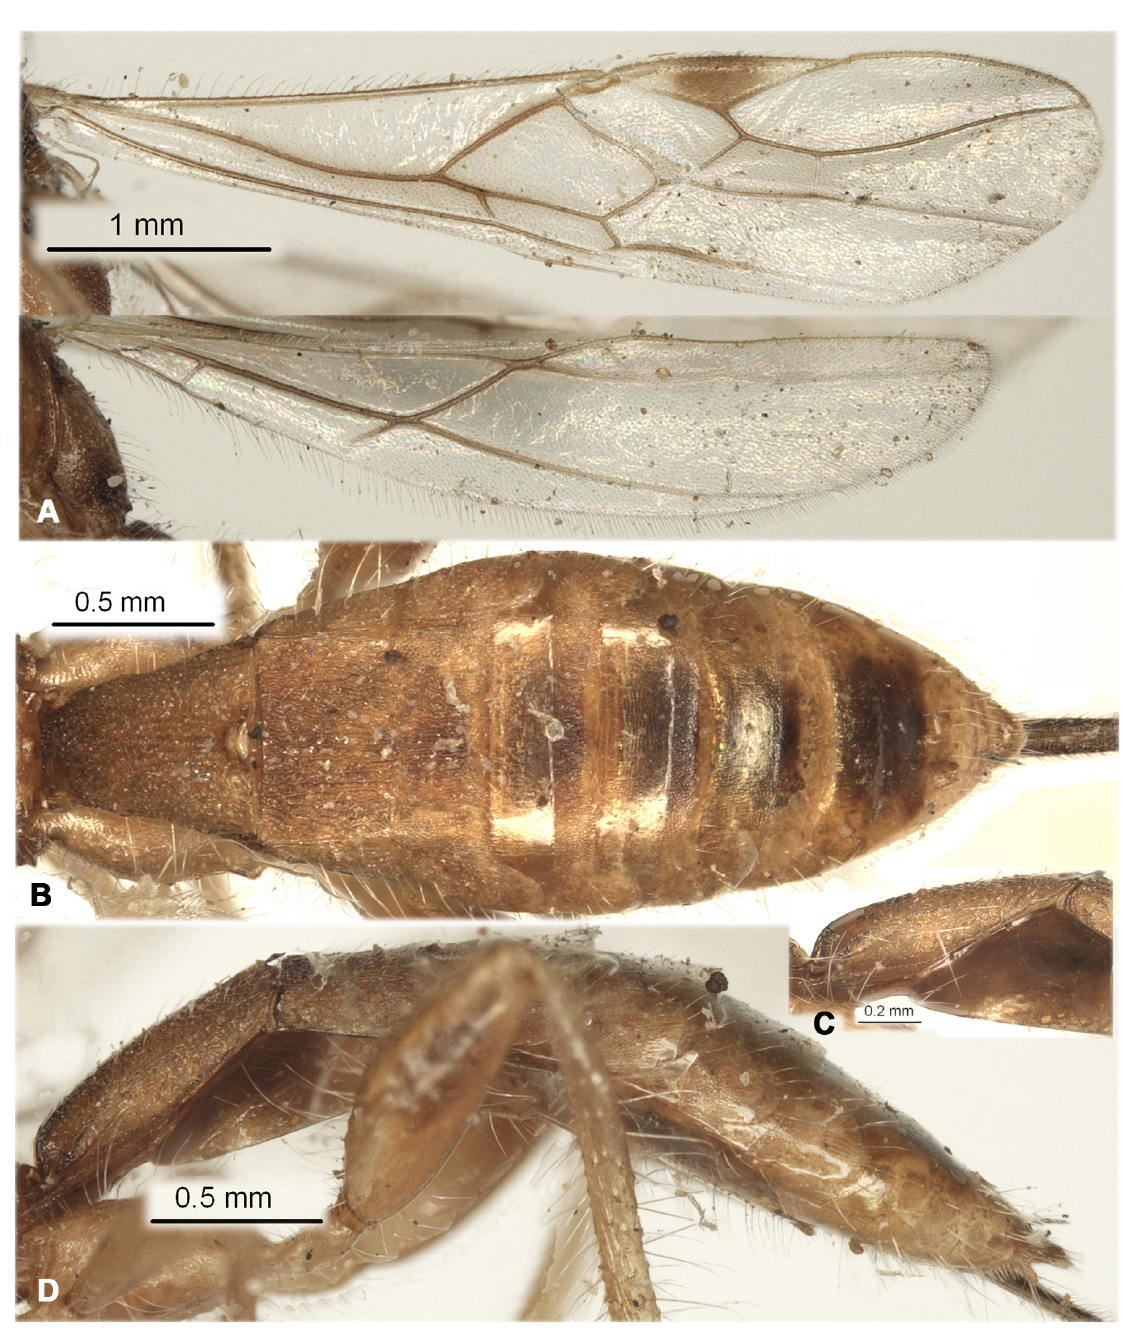
Fig. 10. Hemispathius pilosus (Granger, 1949) comb. nov., paralectotype, ♀ (MNHN). A . Wings. B . Metasoma, dorsal view. C . First metasomal segment, lateral view. D . Metasoma, lateral